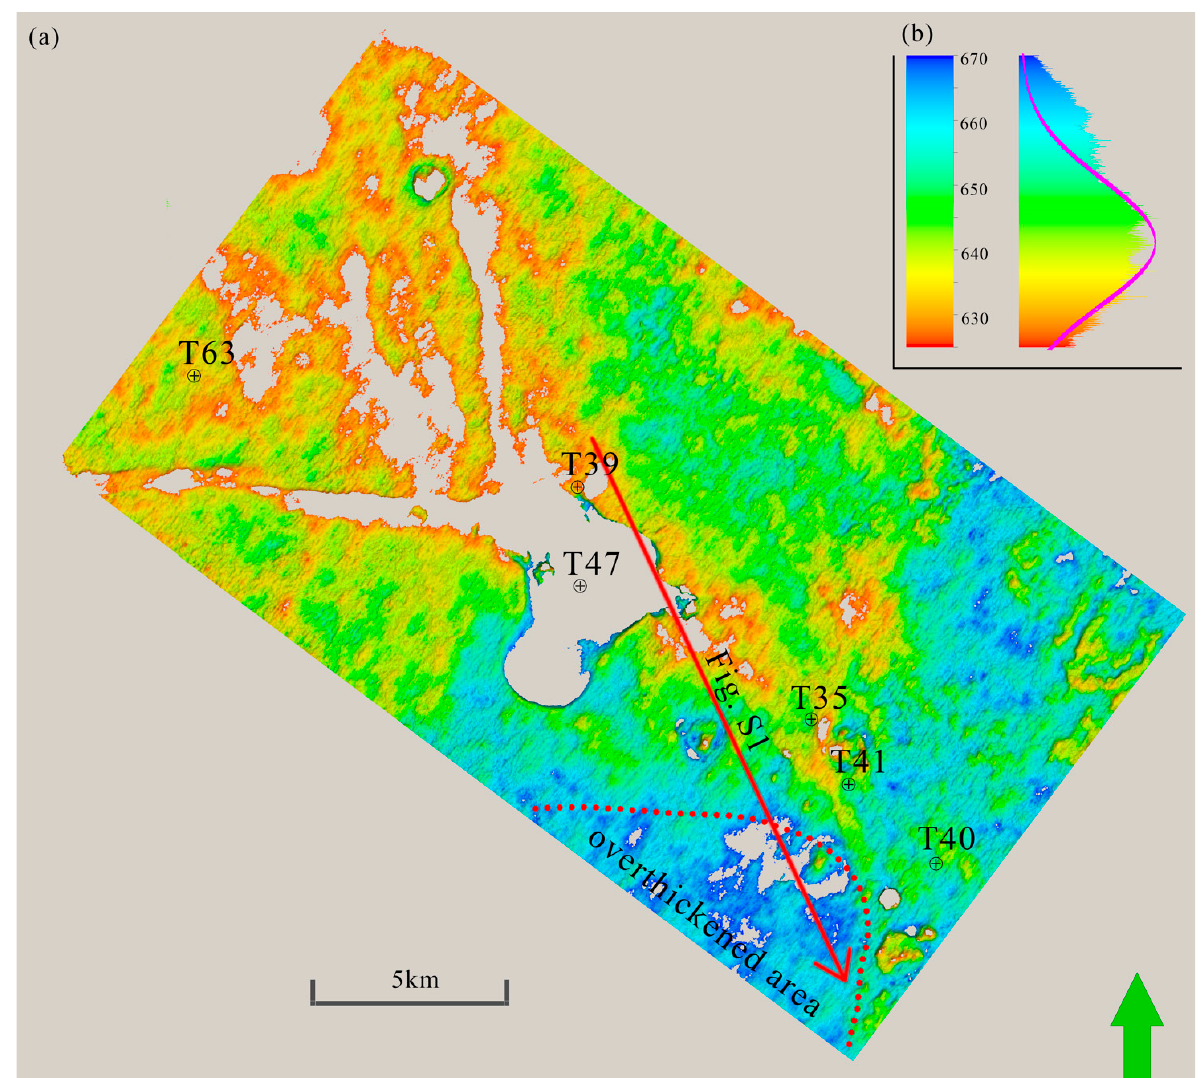
Figure 4. Thickness of the sedimentary strata showing the evenness of the host rocks. ( a ) Thickness isopleth of strata from the basalt top to the “standard limestone” (C4 reflector), gray color indicating eliminated areas subject to sill intrusion and faulting; ( b ) statistics of the thickness data. The overall mean value of all thickness data is 643.29 m, with a standard deviation of 9.98 m, which is biased from the normal distribution curve (thick pink line). The bias from normal distribution is mainly due to the existence of overthickened area as circled by dashed red line at lower right of ( a ). The red arrow indicates the strike of seismic profile Figure S1.